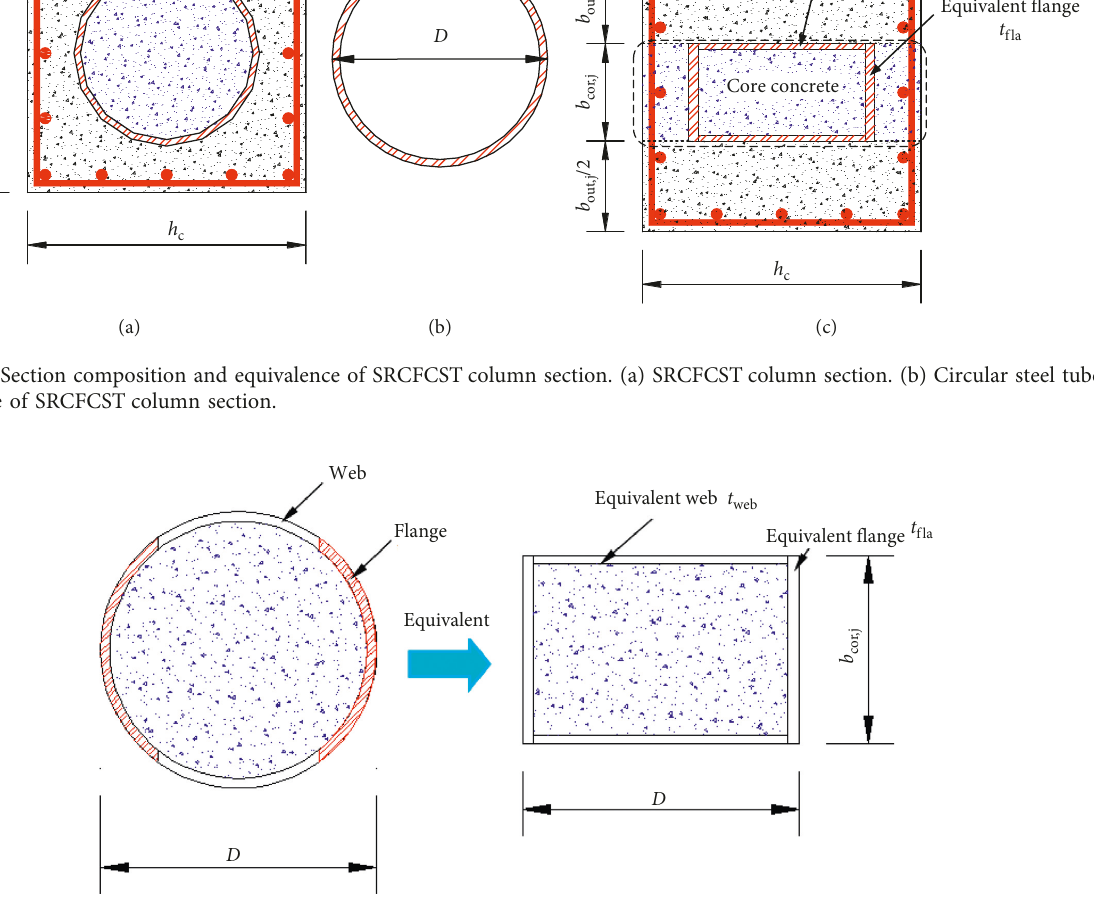
Figure 11: Inner concrete of tube and steel tube equivalent